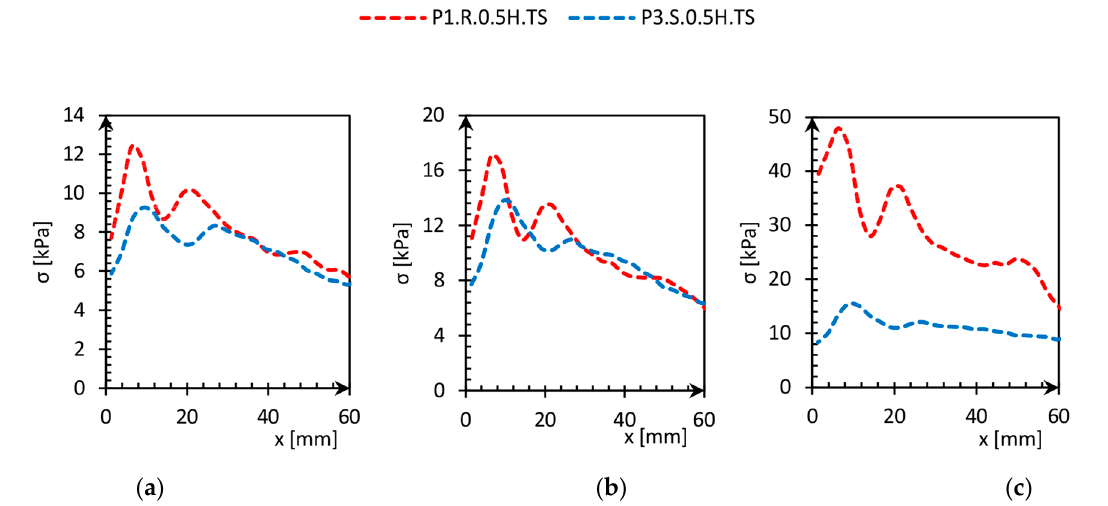
Figure 23. Stress redistribution versus distance from the pile skin (x) of P1.R.0.5H.TS and P3.S.0.5H.TS. ( a ) P1.R.0.5H.TS—